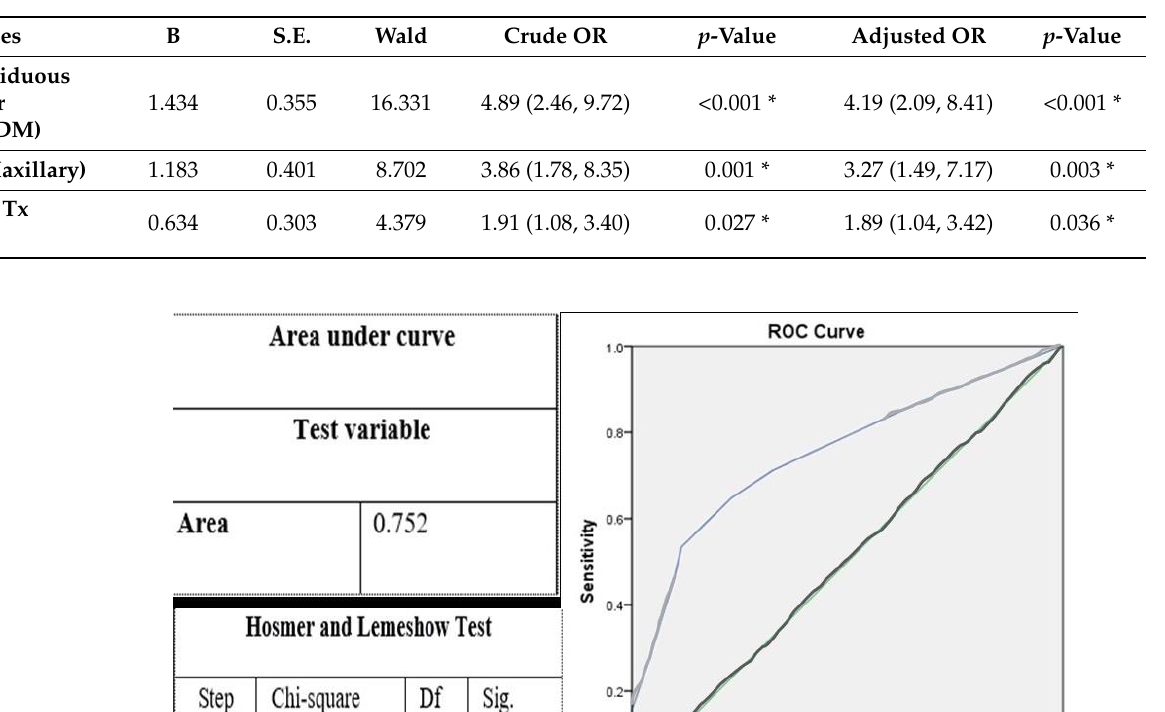
Table 3. Logistic regression model showing the crude and adjusted OR (95%CI) for successful treatment outcomes according to clinically observed variables. * Significant p -value.